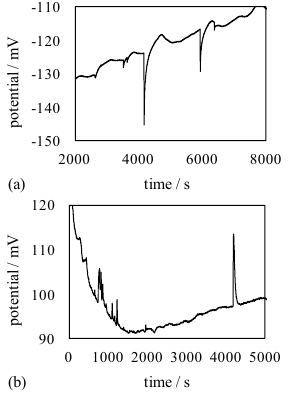
Figure 9. Membrane potential generated across ( a ) a silver wire & S ‐ penta and ( b ) a silver wire & C ‐ penta.